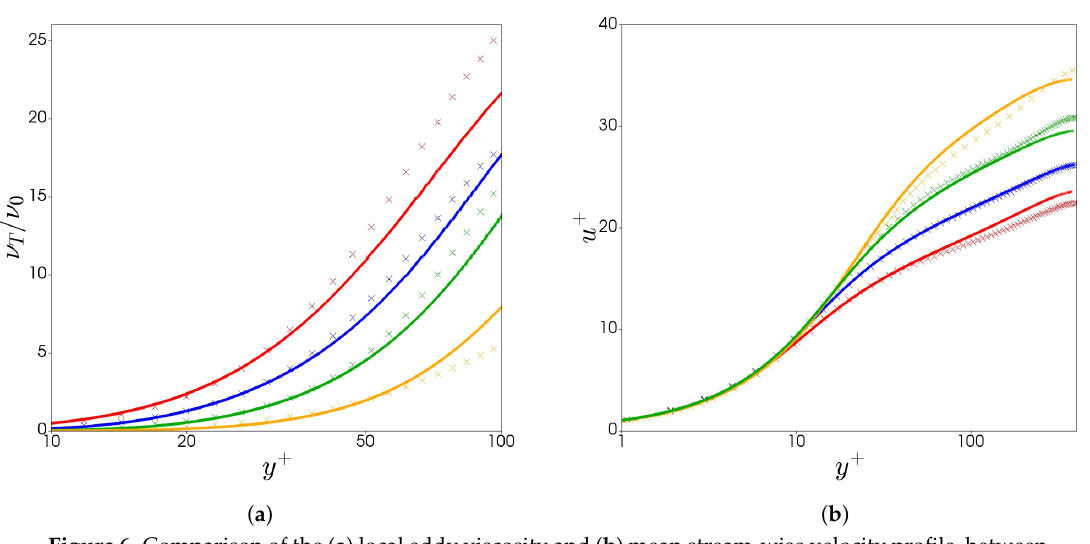
Figure 6. Comparison of the ( a ) local eddy viscosity and ( b ) mean stream-wise velocity profile, between DNS data ( × crosses) and model predictions (continuum lines). Each colour represents a different drag reduction regime: red (LDR case 16); blue (IDR case 19); green (HDR case 20); orange (very HDR case